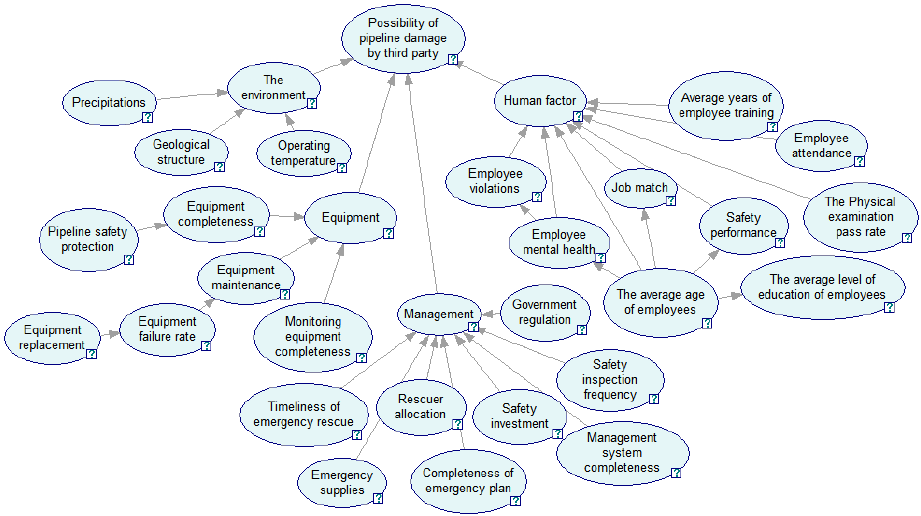
Figure 3. Optimized Bayesian network diagram.